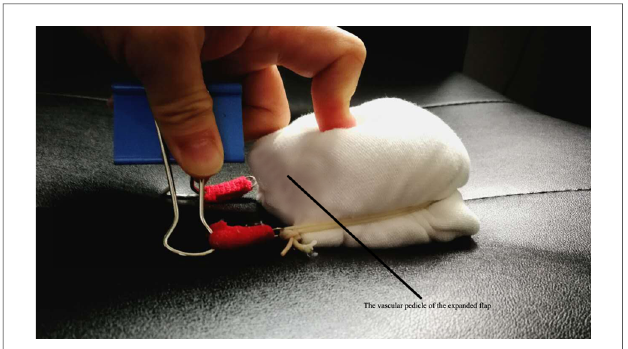
FIGURE 2 Device for testing the circulation of the expanded fl